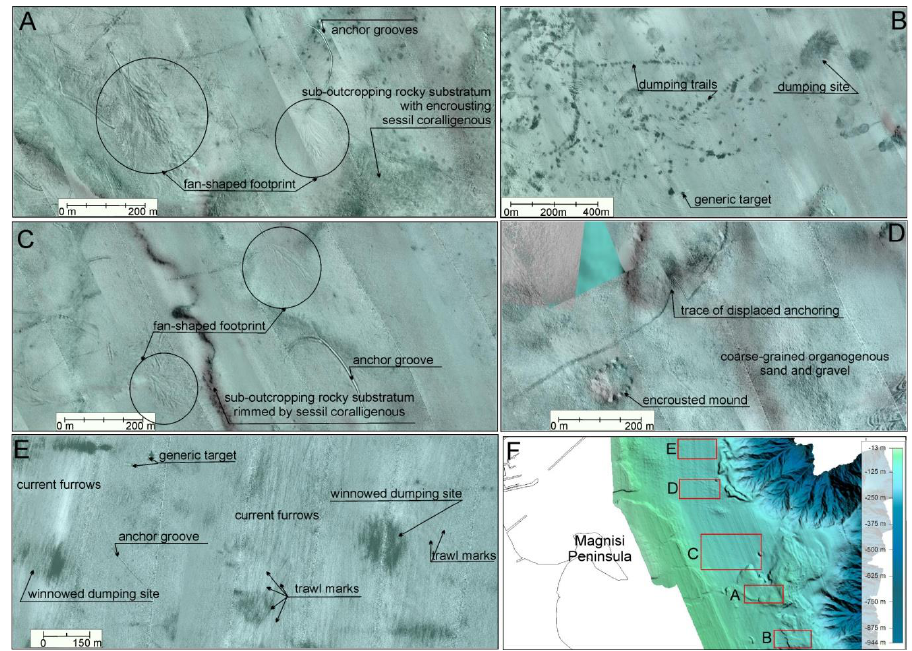
Figure 4. Selected acoustic images of the seabed and: ( A ) and ( C ) anchor grooves leave deep furrows in the seabed; associated fan-shaped scars occasionally develop at the end of the slick and seem to pertain to anchor chain abrasion on the sea bed; ( B ) acoustic images of dumping trails and sites are easily distinguishable by backscatter contrast between discharged materials and pre-existing sediments; ( D ) trace of an anchor chain displacement; ( E ) dredge spoils dumping sites, winnowed by seabed currents and trawl fisheries; ( F ) location of A-E.